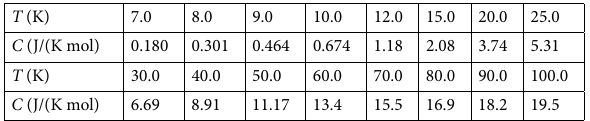
Table 2. Specific heat of grey tin, Ref. 39